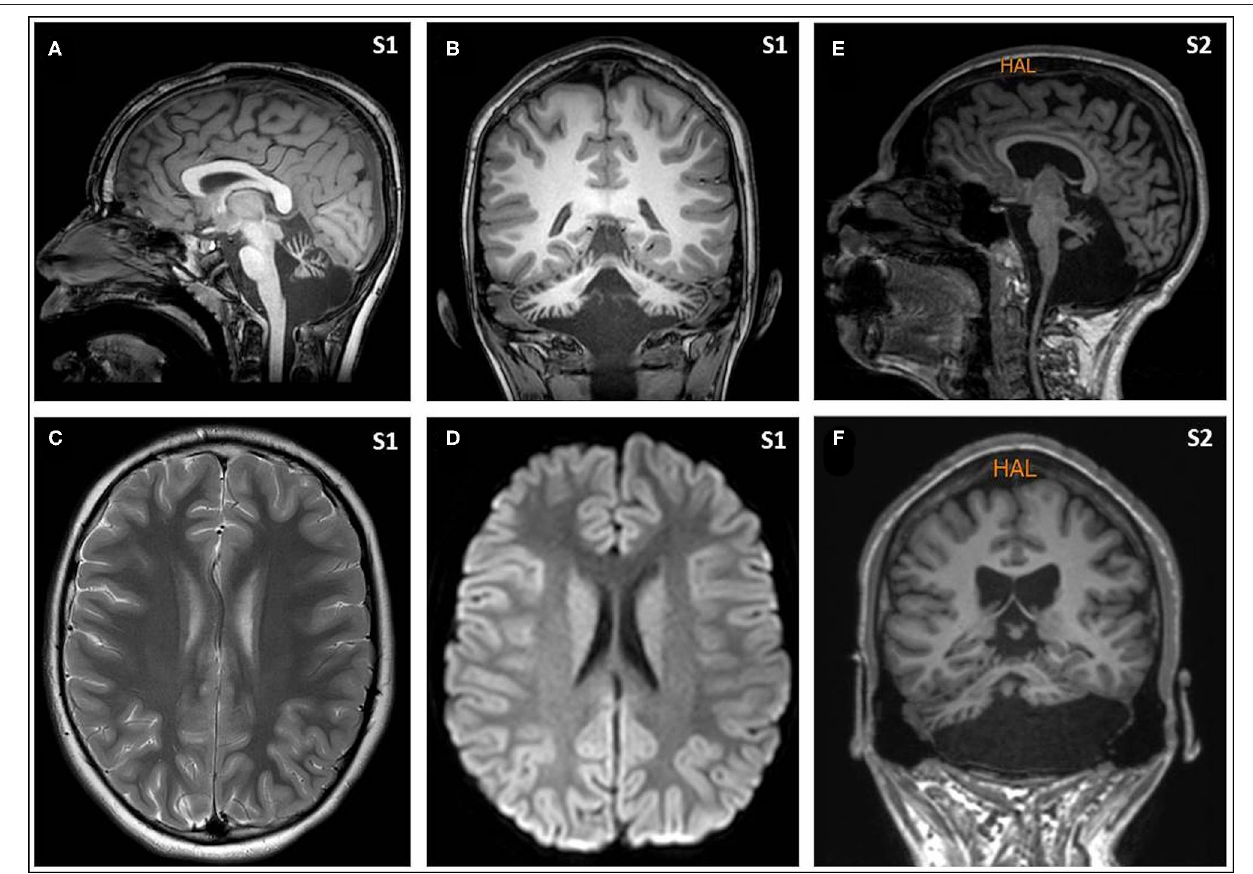
FIGURE 1 | Magnetic resonance imaging (MRI) from Subjects included T1- and T2-weighted images and FLAIR, diffusion weighted images, and an arterial and venous angiographic study, performed with a 3T and 1.5T scanners, respectively. There was no abnormal finding other than the cerebellar atrophy. Sagittal [ (A) from Subject 1, and (E) from Subject 2] and coronal images [ (B) from Subject 1, and (F) from Subject 2] show the small cerebellar vermis with enlarged interfolial spaces representing atrophy and secondary enlargement of the fourth ventricle. Axial supratentorial images (C) , including diffusion weighted images (D) , from Subject 1 show no other